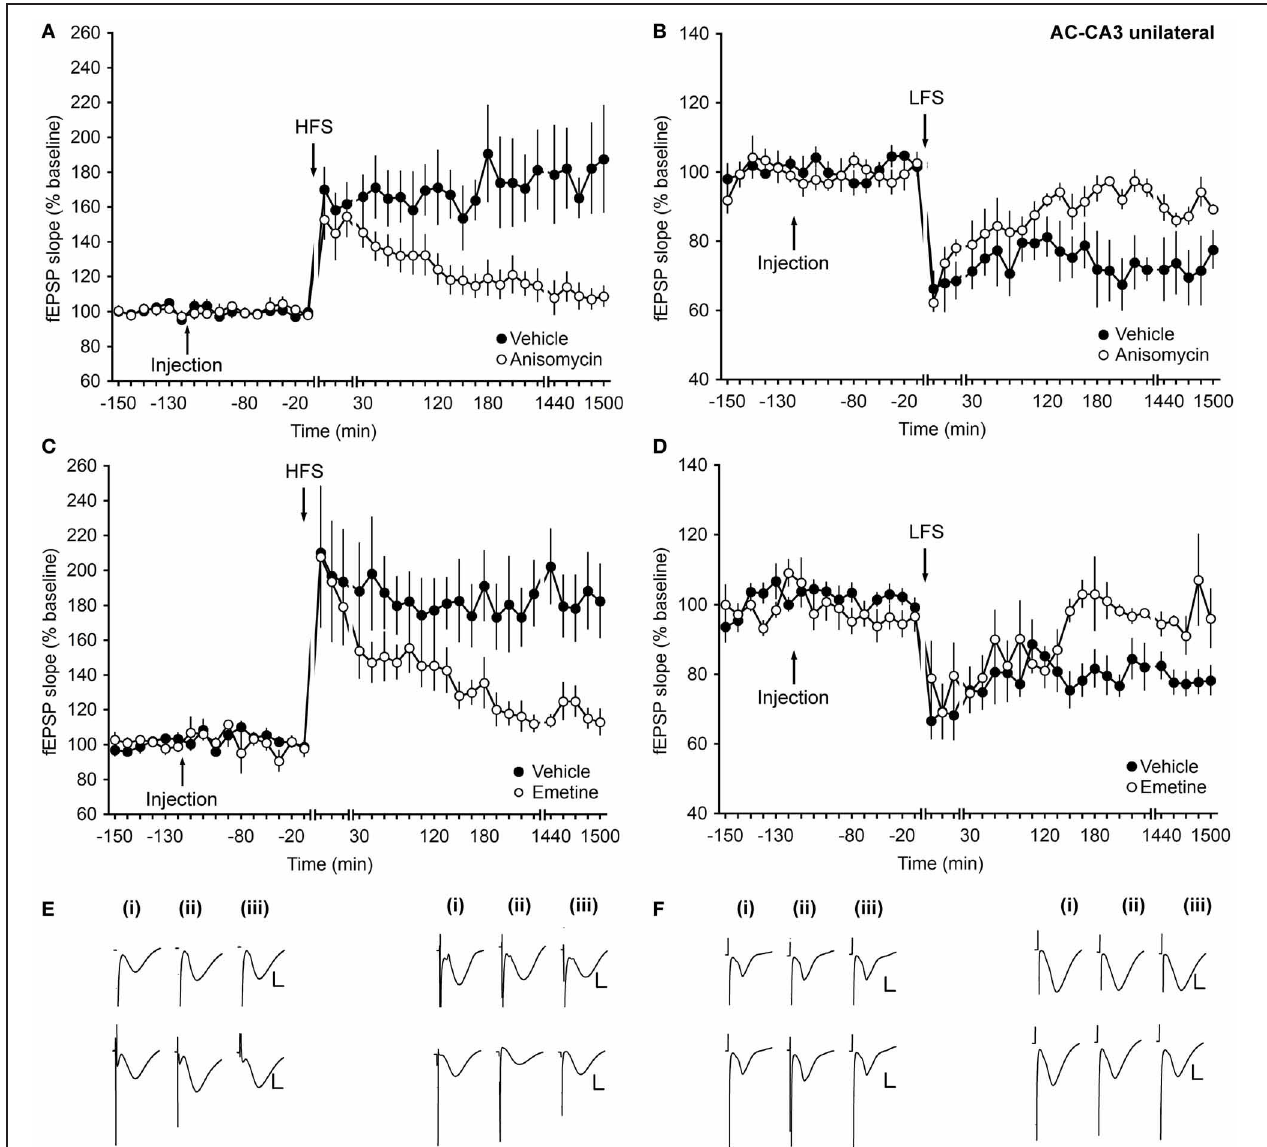
scale bar: 2mV, horizontal scale bar: 8ms. Traces in the right panel show analogs that represent fEPSP responses obtained pre-LFS (i) , 5min post-LFS (ii) , and 24h (iii) after LFS in the presence of vehicle (upper traces) or anisomycin (lower traces). Vertical scale bar: 2mV, horizontal scale bar: 8ms. (F) Analog traces in the left panel represent fEPSP responses recorded pre-HFS (i) , 5min post-HFS (ii) , and 24h after HFS (iii) in the presence of vehicle (upper traces) or emetine (lower traces). Vertical scale bar: 2mV, horizontal scale bar: 8ms. Analogs in the right panel represent fEPSP responses recorded pre-LFS (i) , 5min post-LFS (ii) , and 24h after LFS (iii) in the presence of vehicle (upper traces) or emetine (lower traces). Vertical scale bar: 2mV, horizontal scale bar: 8ms.